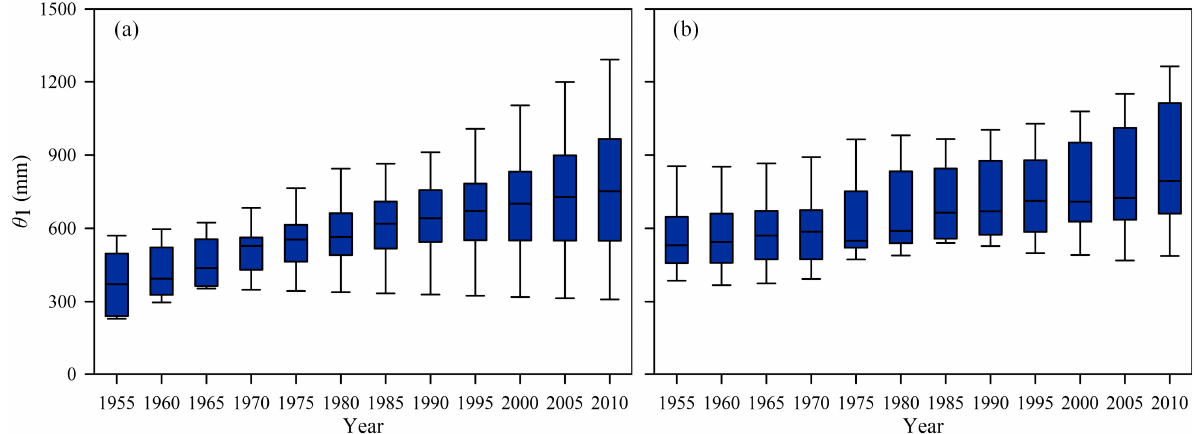
θ Figure 5. Annual variation of the parameter 1 in model one ( a ) and model two ( b ). Figure 5. Annual variation of the parameter θ 1 in model one ( a ) and model two ( b ). For both models one and two, the increasing trend in the parameter θ 1 is